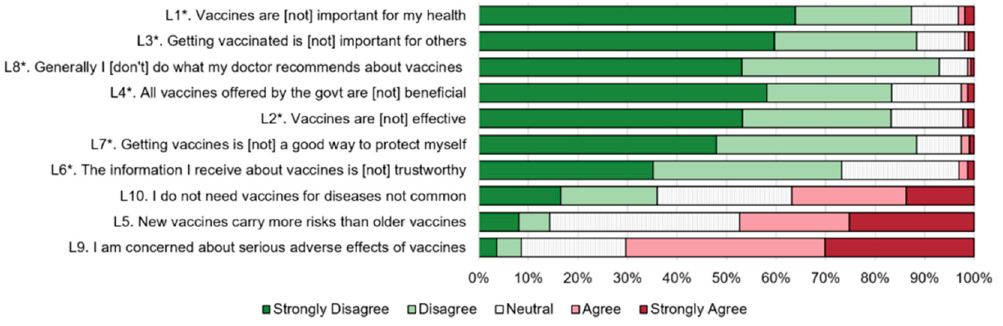
Figure 1. Responses to questions about vaccine hesitancy among parents of school-aged children in Shanghai, China, 2020. Questions with an asterisk (*) have been reverse coded so that all questions have responses with higher values being more vaccine